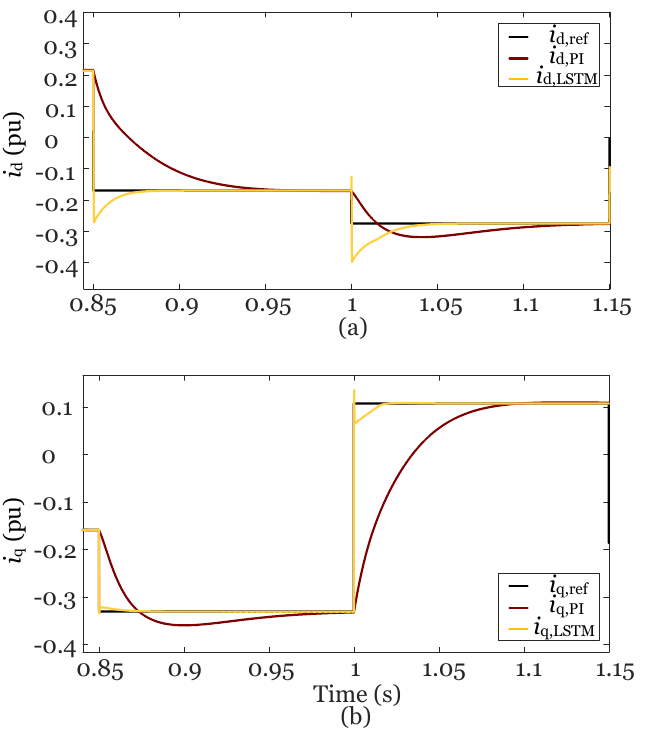
Figure 16. Controller response to 20% decrease in the inductance of the grid filter. ( a ) i d , ref change; ( b ) i q , ref